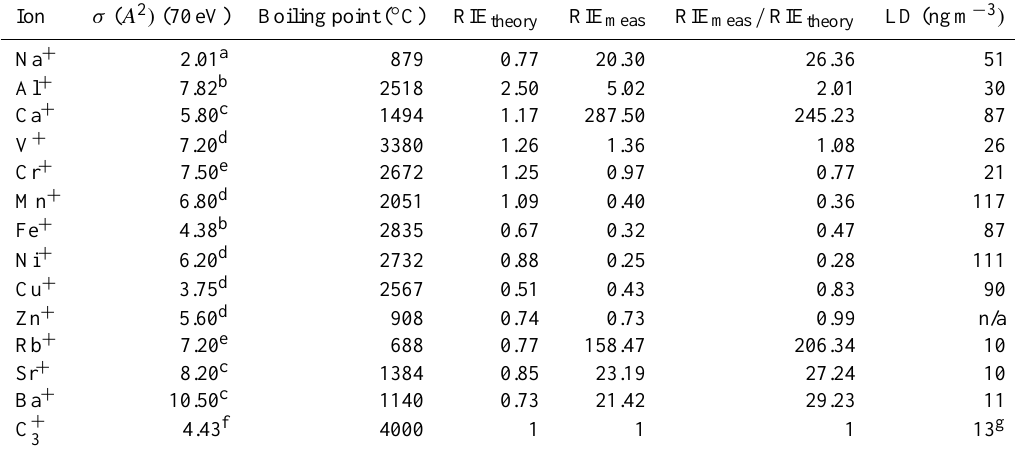
Table 2. Metallic ions evaluated in the laboratory experiment, electron impact cross section ( σ) , theory relative ionization efficiency (RIE T )